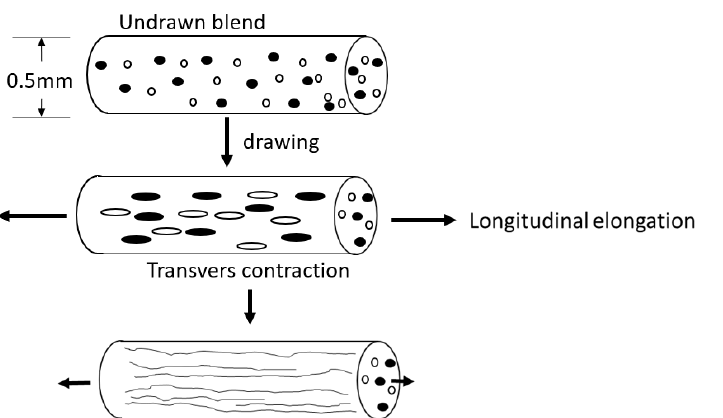
Figure 2. Melt blends cold drawn to make fibres; discontinuous pitch domains are stretched from spheres to ellipses.